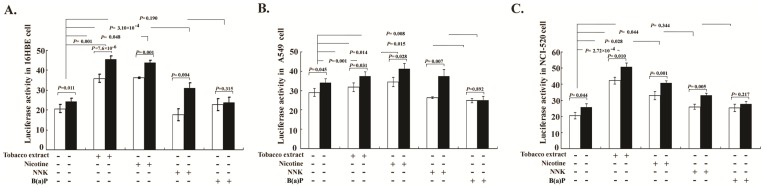
Luciferase expressions in different cell lines under the treatment of tobacco components.
A, 16HBE. B, A549. C, NCI-520. Columns, mean from three independent experiments; bars, SD; and the difference of luciferase activity between C/T allele and the luciferase activity levels by chemical treatment (luciferase activity with chemical treatment – luciferase activity without treatment) were analyzed by Student’s t test Tobacco extract, nicotine and NNK could induce a significantly higher increased luciferase activity driven by the rs6495309C allele than that driven by the T allele.